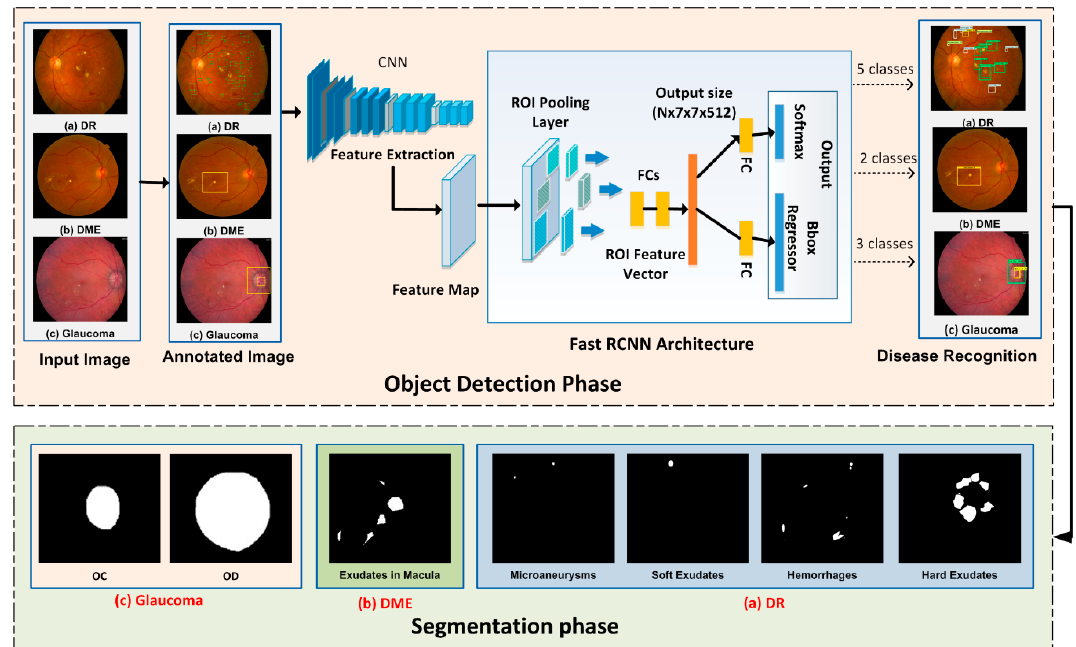
Figure 1. Framework of the proposed method. In the object detection phase, the ROI for the concerned disease is detected using FRCNN. In the segmentation phase, the detected regions of all three diseases are segmented out through FKM clustering.